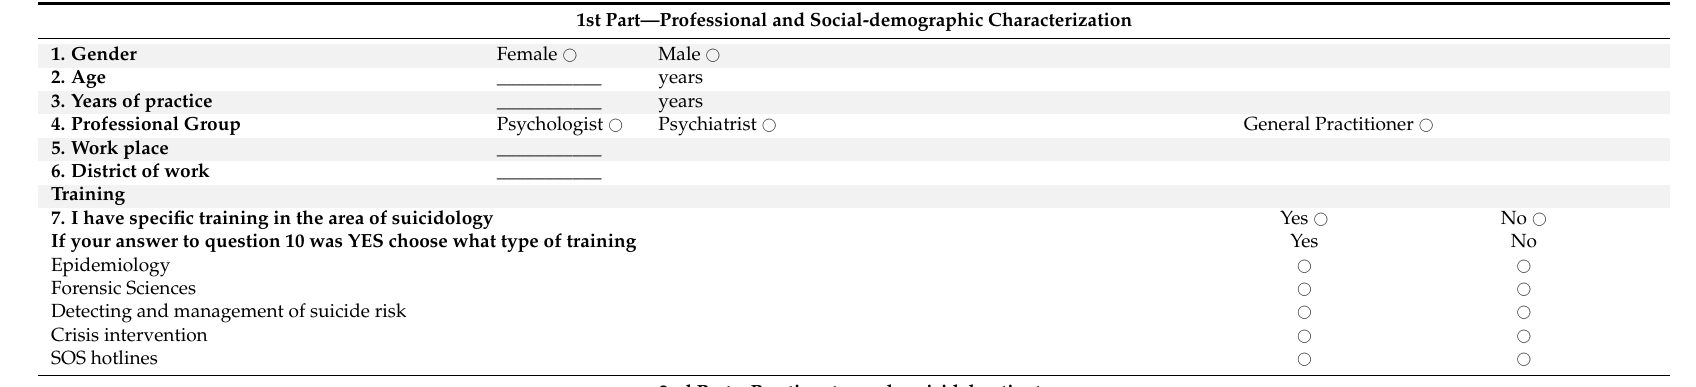
Table A1. Intervention Strategies towards Suicidal Behaviours Questionnaire